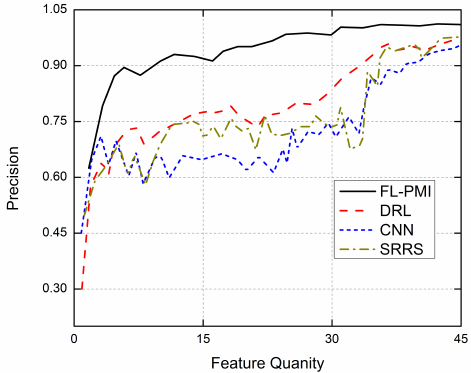
Figure 8. Precision Analysis for varying feature quantities.